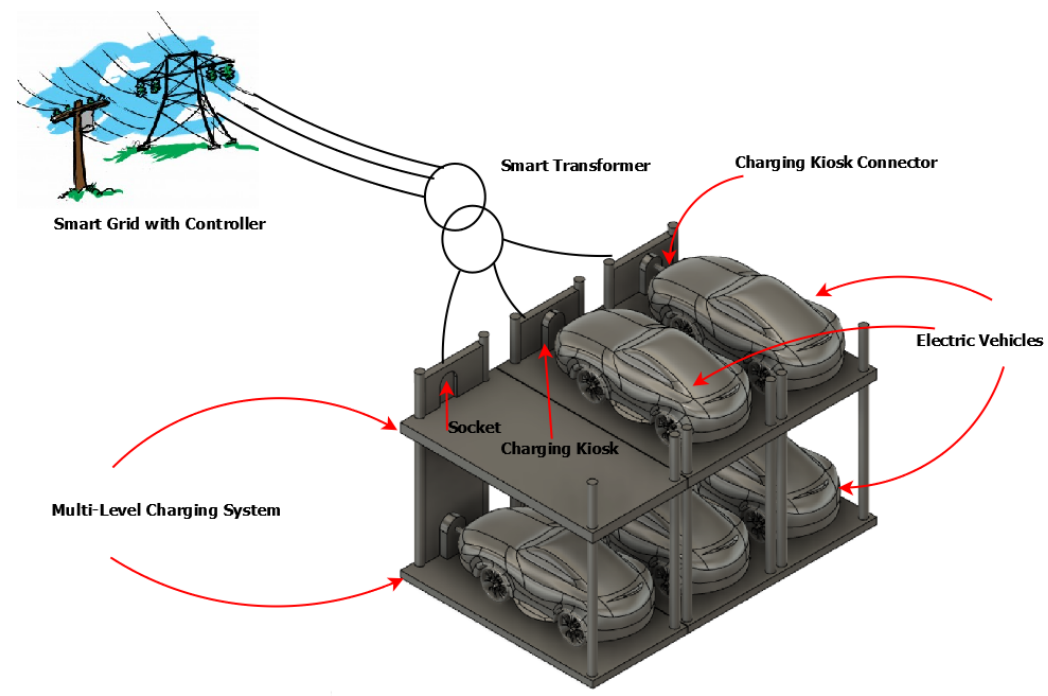
Figure 1. Multi-Level EVs Charging Design CAD Model.